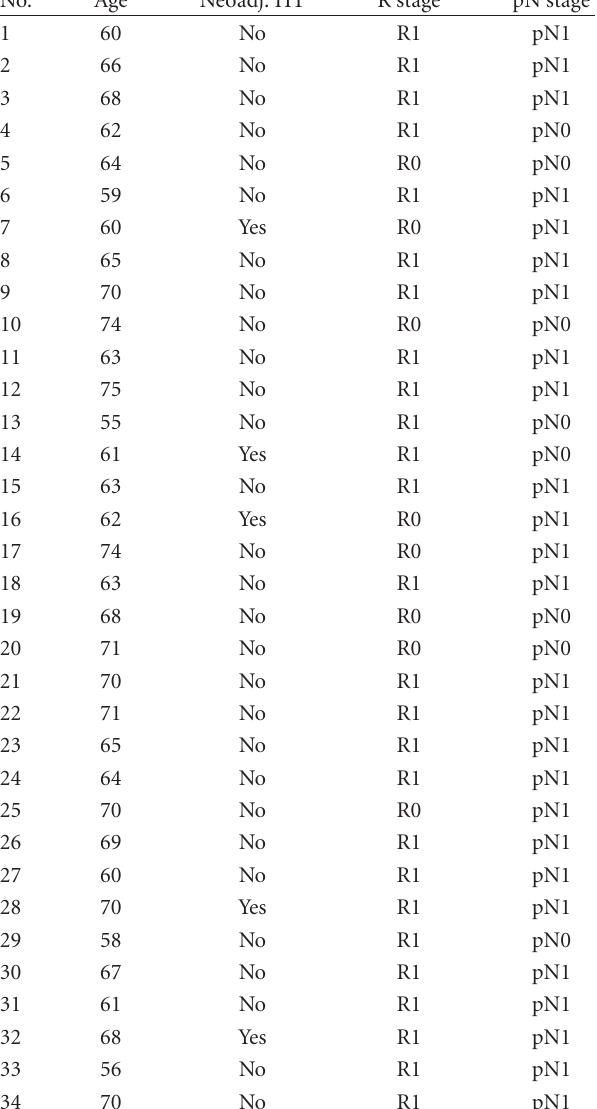
Table 2: Association of positive margins with lymph node metasta-